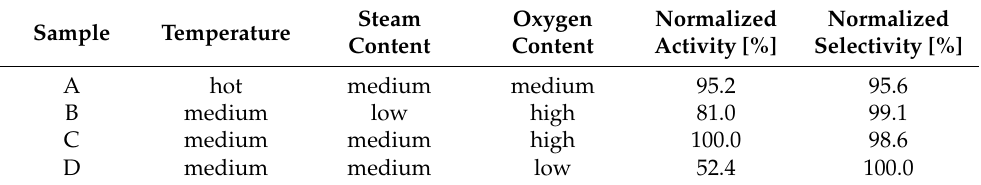
Table 1. Summary of the varied preparation conditions during the activation process (values are given relative to the values stated in [18]) and of normalized catalytic performance data of the sample